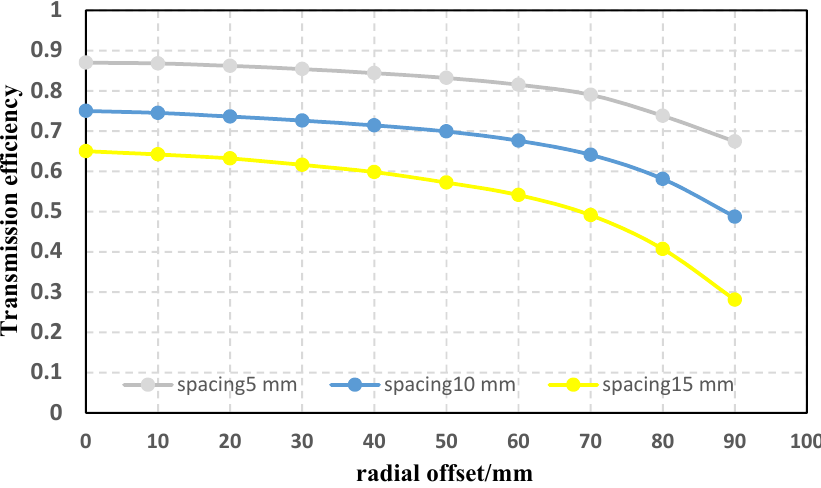
Figure 16. Transmission efficiency and anti-offset capability of the new coils at different spacings.